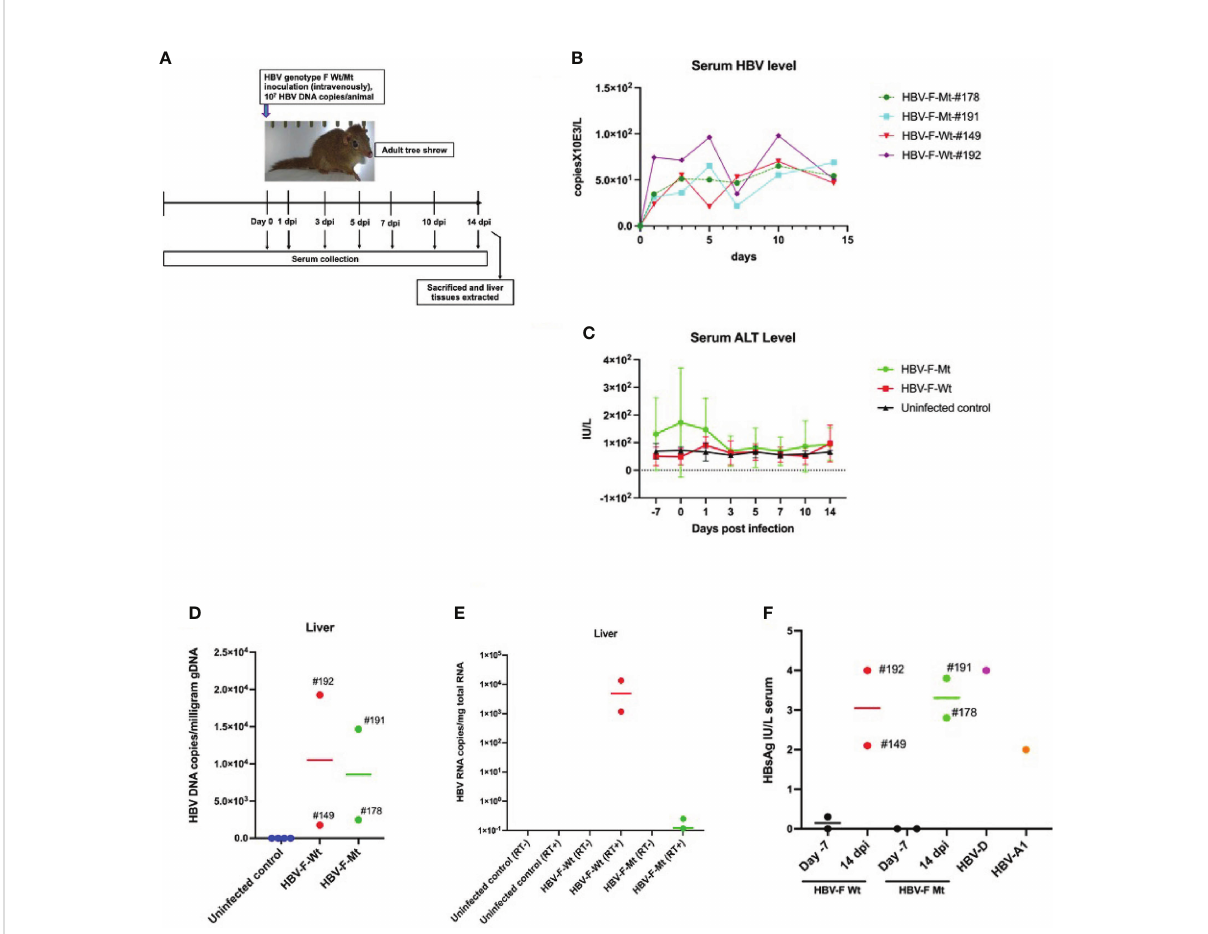
FIGURE 1 HBV genotype F wild-type or mutant-type (HBV-F Wt#149 and 192/Mt#178 and 191) infections in adult tree shrews. (A) Experimental design of HBV-F infection in tree shrew. (B) Serum HBV levels from day 0 to day 14 in HBV-F Wt/Mt-infected tree shrews. (C) Serum alanine aminotransferase (ALT) levels from day -7 (before infection) to 14 dpi in HBV-F Wt/Mt-infected and uninfected controls. Error bars indicate standard deviation. (D) Intrahepatic HBV DNA loads in HBV-F Wt/Mt-infected tree shrews at 14 dpi. (E) Intrahepatic HBV RNA levels in HBV-F Wt/Mt-infected tree shrews at 14 dpi. (F) Serum hepatitis B surface antigen (HBsAg) levels in HBV-F Wt/Mt-infected tree shrews at 7 days before infection (Day -7) and 14 dpi. Serum HBsAg levels in HBV-D-infected tree shrew after 10 weeks post infection and in HBV-A1-infected tree shrew after 39 weeks post infection were shown (right). Thick horizontal lines indicate arithmetic